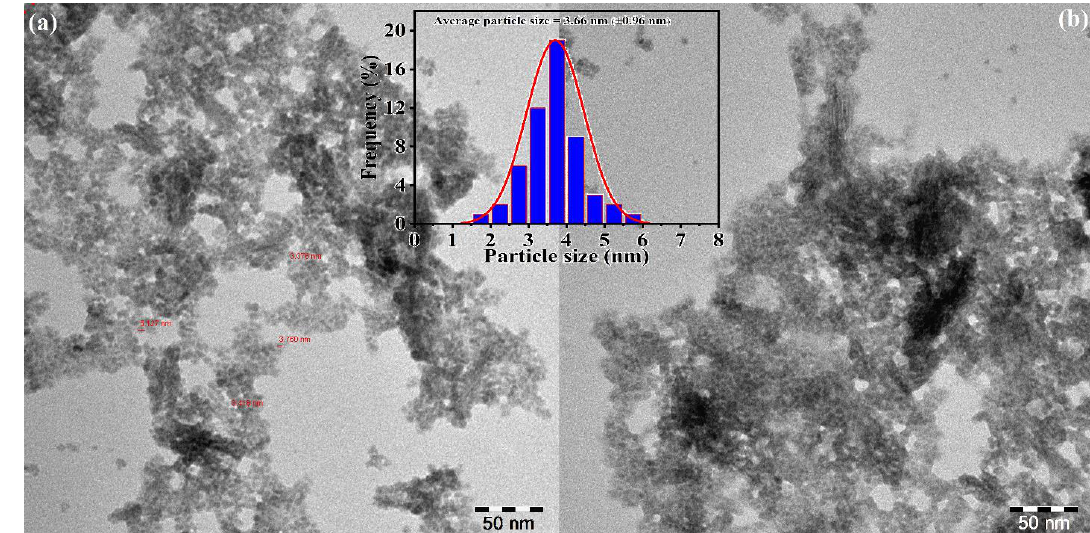
Figure 5. Transmission electron microscope (TEM) images ( a,b ) and particle size distribution histogram ( insert ) of PdNPs.